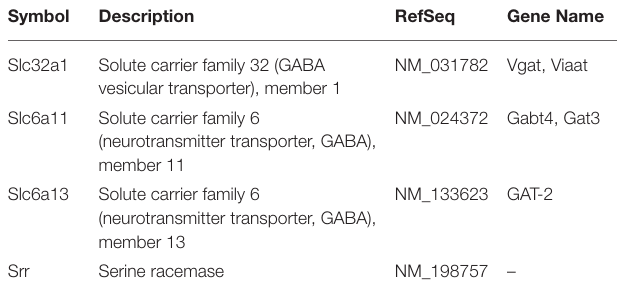
TABLE 2 | The list of genes with statistically significant ( P < 0.05) expression